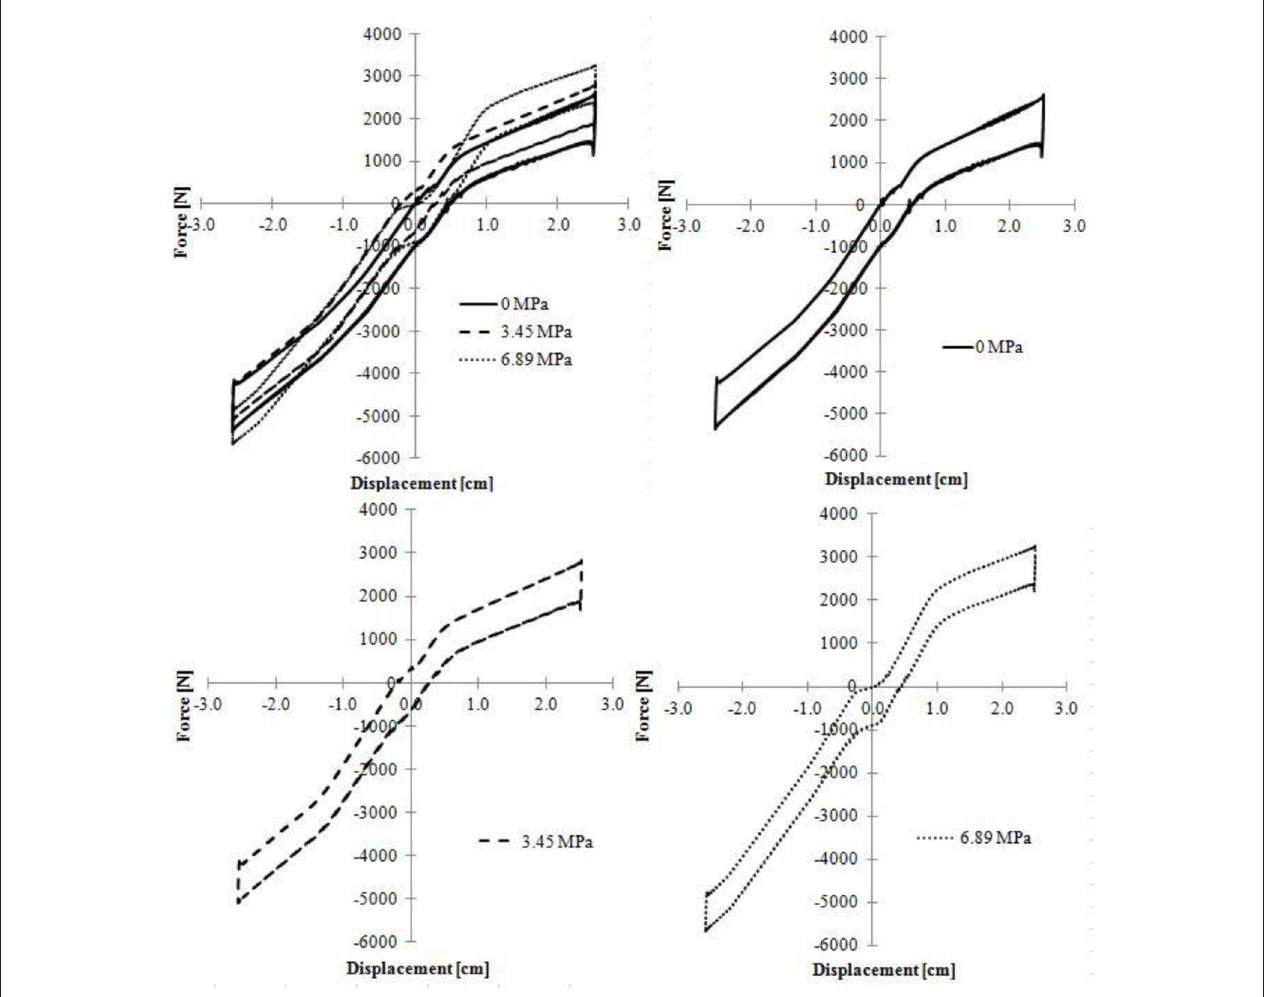
FIGURE 11 | Comparison of quasistatic symmetric, symmetrically pressurized force displacement curves at 0, 3.45, and 6.89 MPa shows the development of the multi-linear regions.